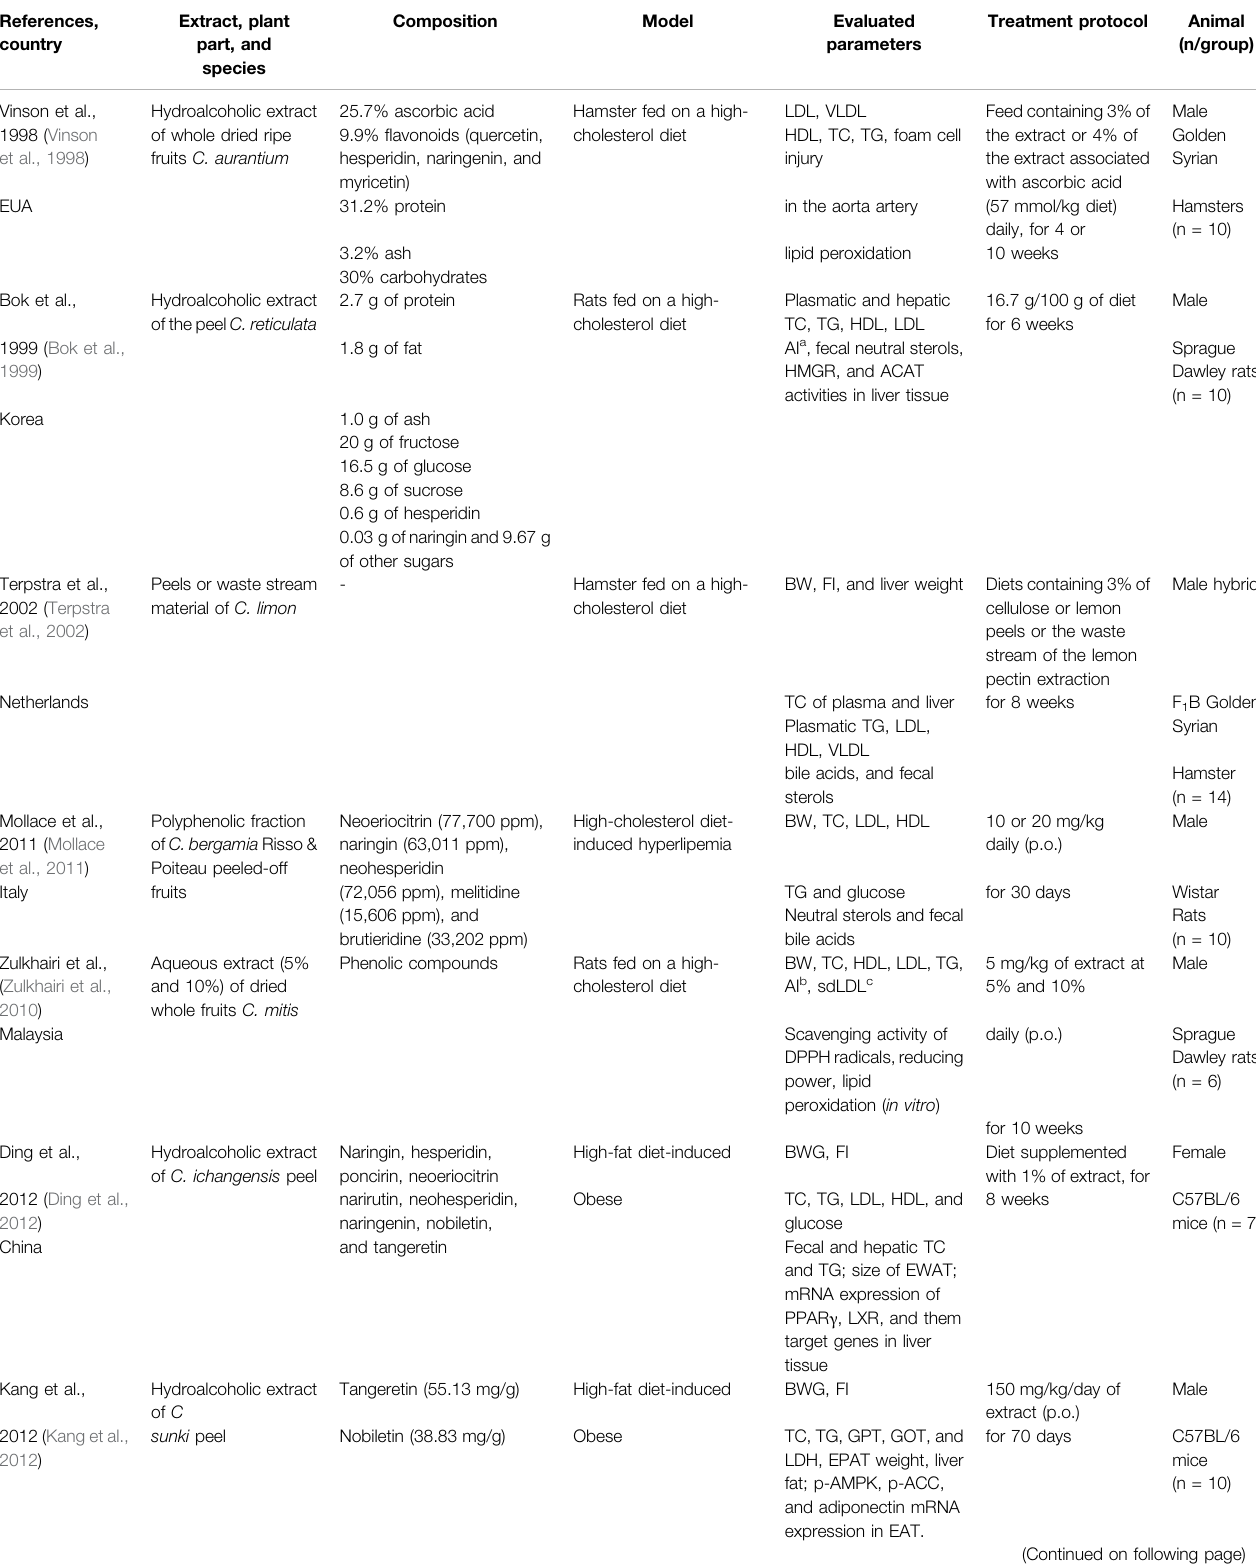
TABLE 1 | Detailed description of the preclinical studies of the effect of Citrus extract on hyperlipidemia included in the systematic review. References,